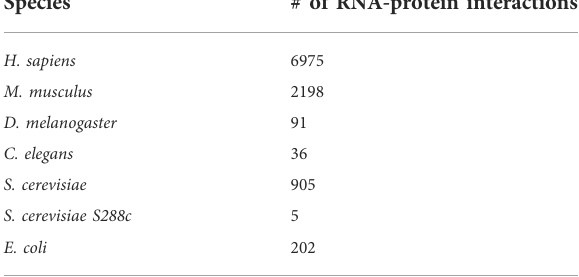
TABLE 1 Number of RNA-protein interactions by species in the NPInter10412 dataset. Species # of RNA-protein interactions